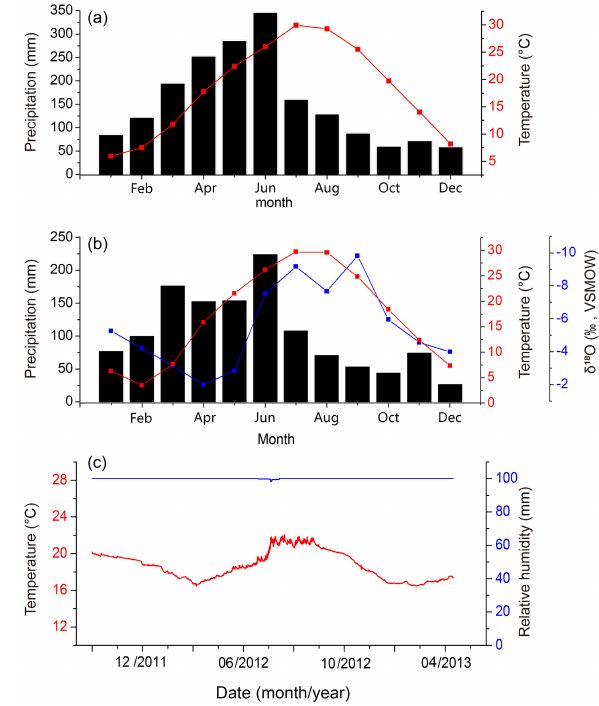
Figure 2. Mean monthly temperature, precipitation and δ 18 O value from two meteorological stations close to the study area and en- vironmental monitoring in Shennong Cave. (a) Mean monthly air temperature (red line) and precipitation (black column) from the Guixi meteorological station for 1951–2010. (b) Mean monthly air temperature (red line), precipitation (black column) and δ 18 O value (blue line) from the Changsha GNIP station for 1988–1992. (c) Air temperature (red line) and relative humidity (blue line) in Shennong Cave from October 2011 to April